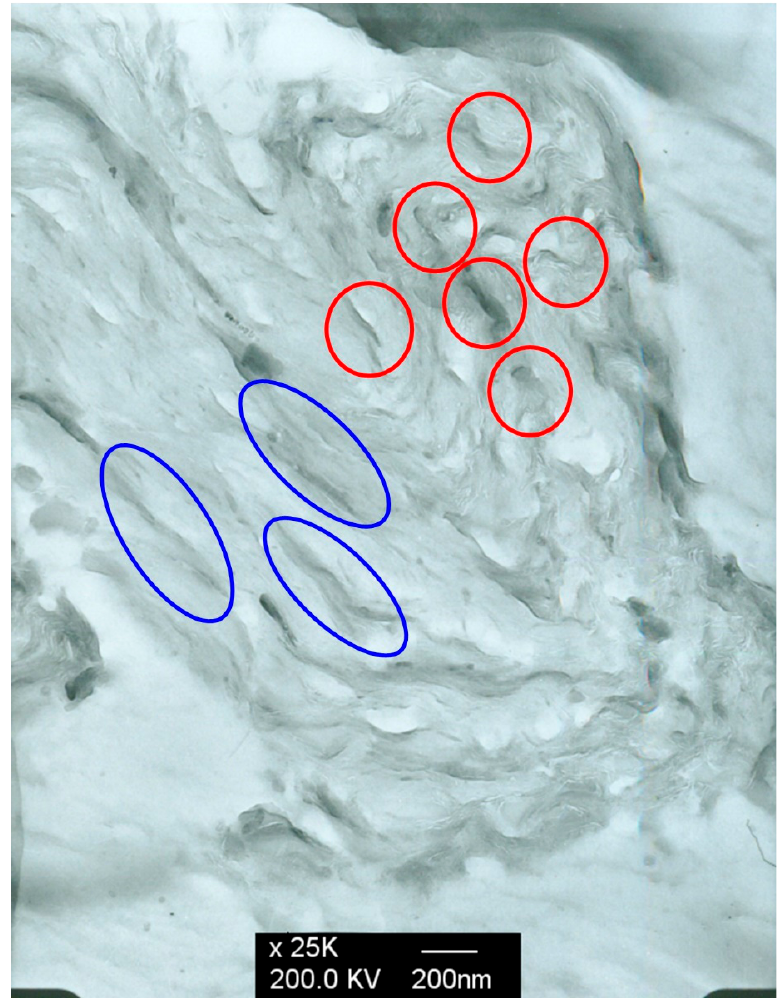
Figure 4. The TEM of PLLA-PEG1000/0.5% o-MMT nanocomposite material (magnification: ×25,000). The red ring shows the exfoliation; the blue ring shows the intercalated structure.